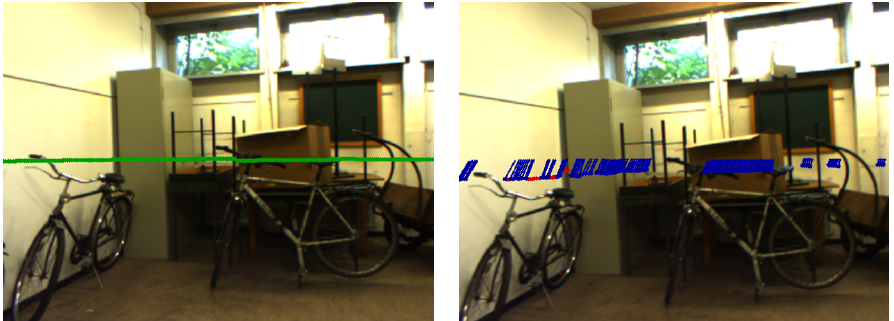
Figure 6. 3D information of the laser rangefinder is projected into the image at reference time k 0 ( left ), and the corresponding pixels are tracked until time k ( right